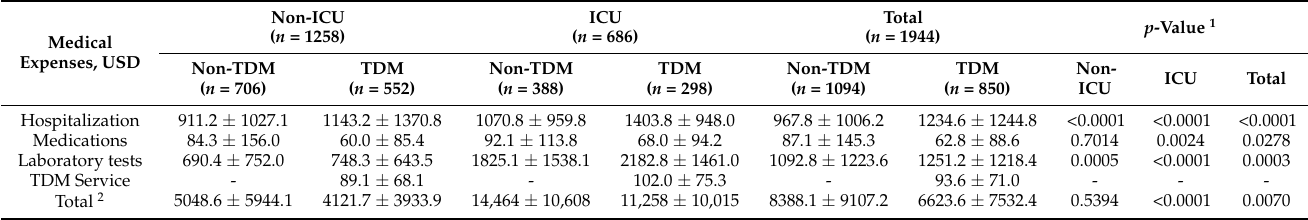
Table 3. Medical expenses by ICU admission and TDM group: univariate analysis.